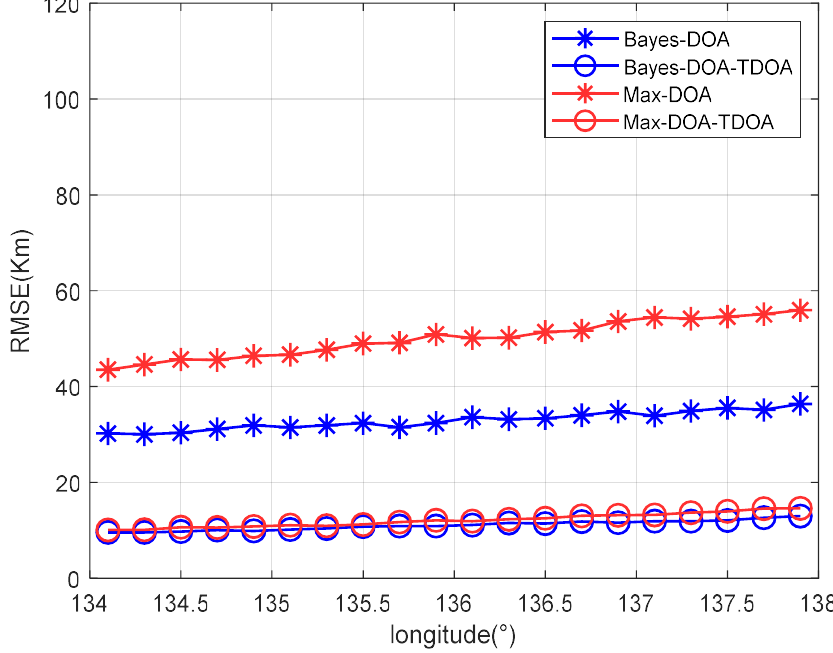
Figure 11. The positioning accuracy varies with the target’s